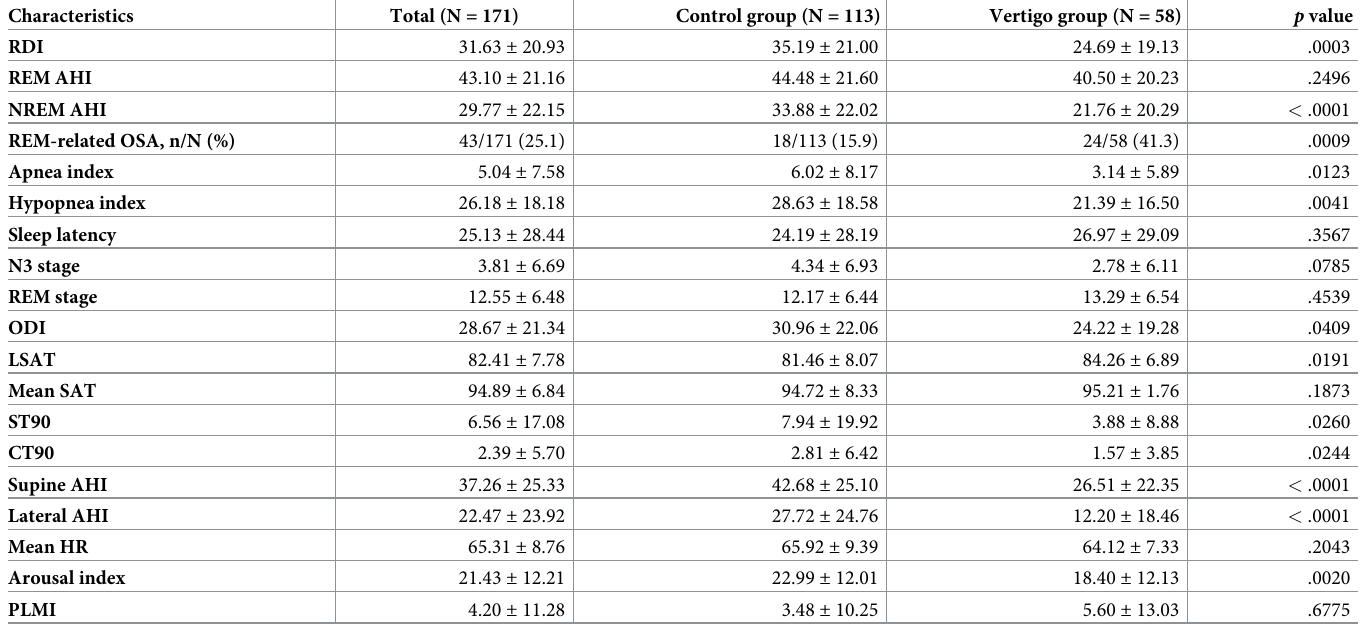
Table 2. Polysomnography results of participants. Characteristics